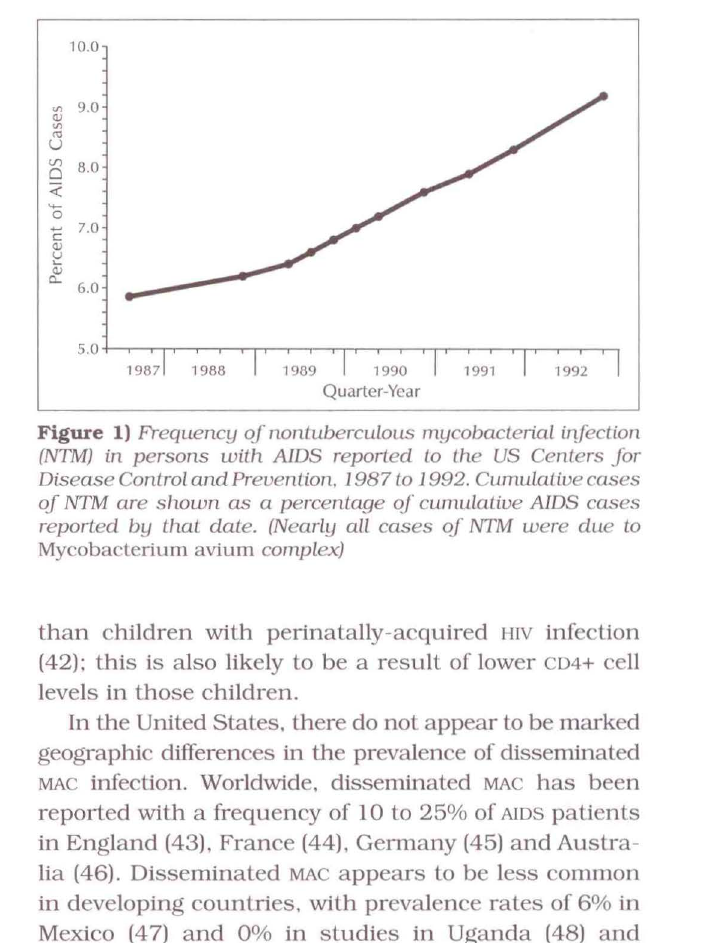
than children with perinatally-acquired 111v infection (42): this is also likely to be a result of lower CD4+ cell levels in those